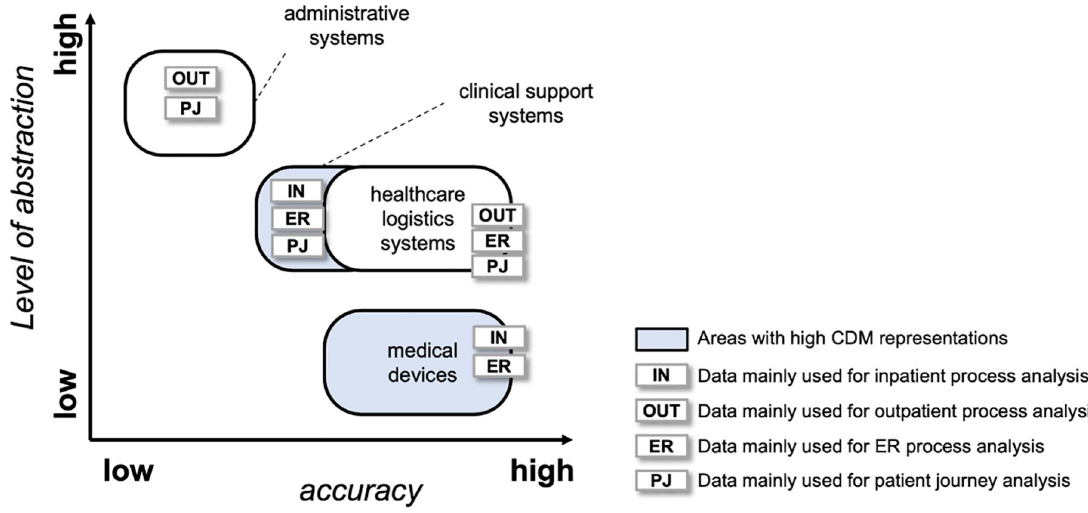
Fig 10. Process mining data spectrum and representation ability of CDM, based on [52].